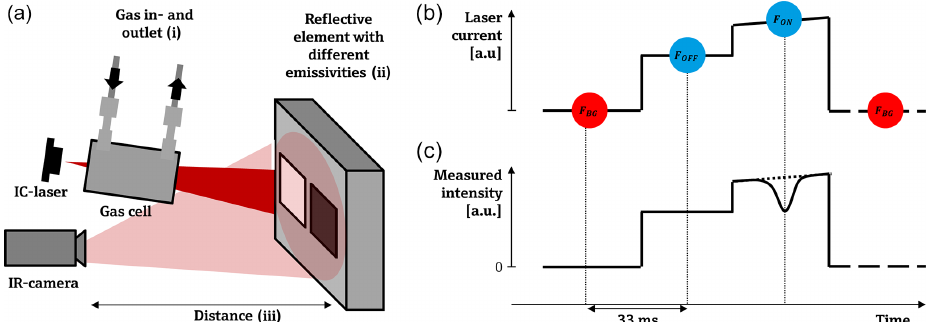
Figure 3. (a) A sketch of the experimental setup to validate the measured concentration length ( c CL ) by varying the methane reference concentration (i), by varying the emissivities of the reflective element (ii), and by varying the distance between the reflective element and the camera (iii). In panel (b) , the laser drive current is plotted vs. time. Within the first section, the laser drive current is set below the lasing threshold of the ICL; the second section drives the laser wave number “beside the absorption line” ν 0 ; and the third section sets the laser wave number on the absorption line, ν p . The ramp in the third section is for the wavelength lock of the laser. (c) The measured intensity for an exemplary pixel is plotted synchronously. The dashed line sketches the intensity if no gas is present, and the solid line shape sketches the gas absorption if gas is present below atmospheric pressures.